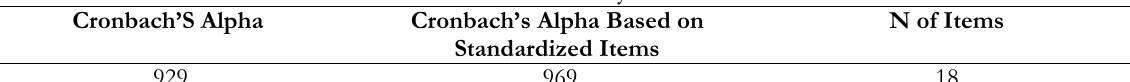
TABLE 1. Reliability Statistics